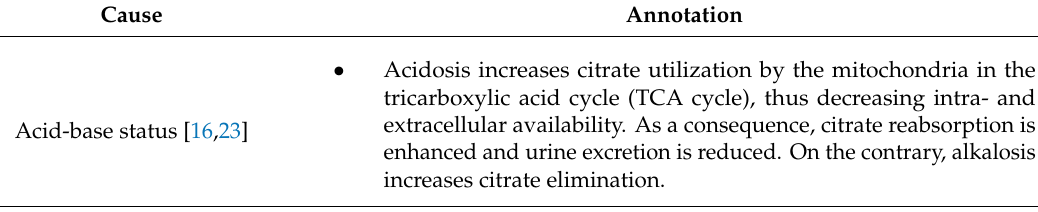
Table 1. Causes of low citrate